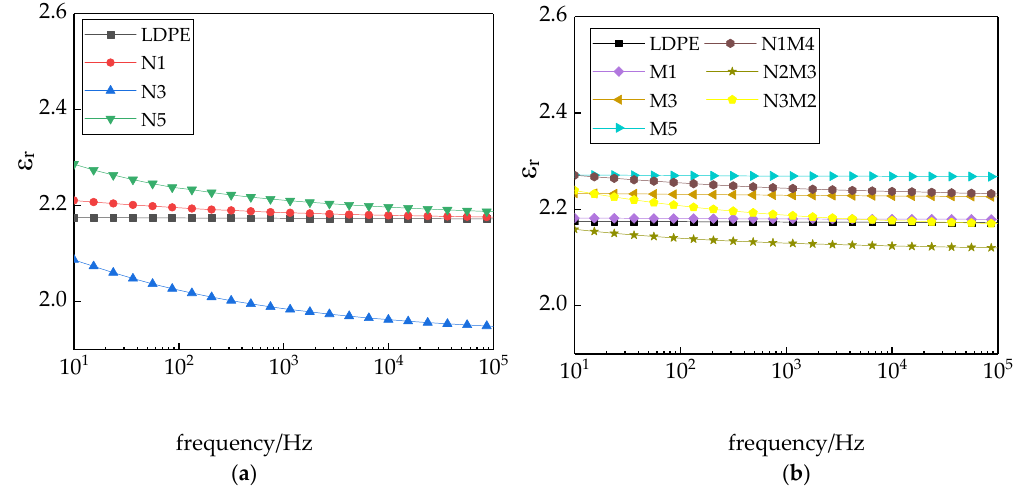
Figure 8. Variation in the dielectric constant of different samples with the frequency: ( a ) LDPE and nano-ZnO/LDPE samples; ( b ) micro ZnO/LDPE and micro-nano-ZnO/LDPE samples.